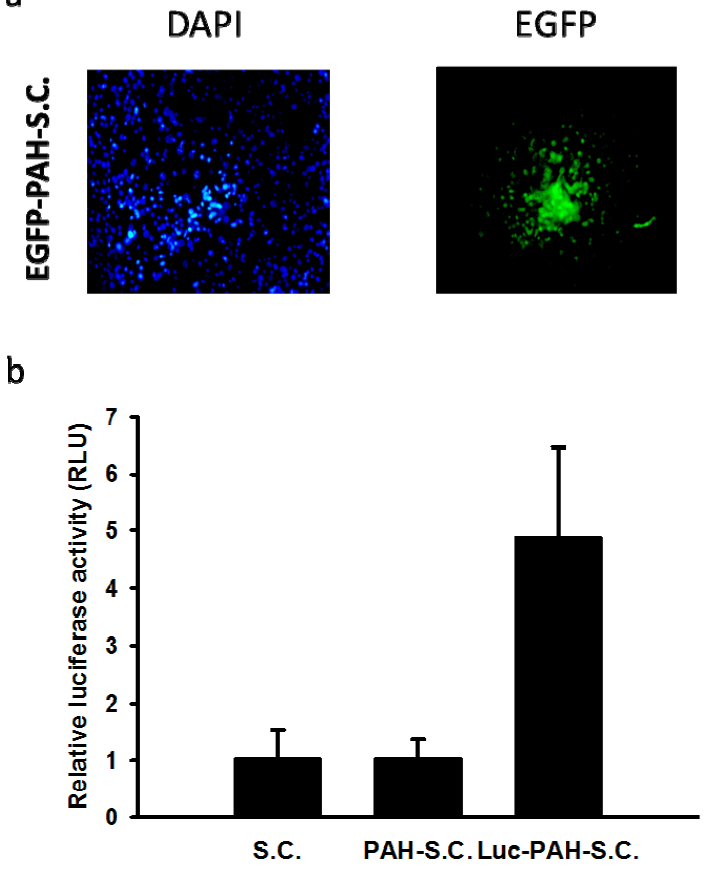
Figure 3. Transduction ability of DNA-PAH-S.C. ( a ) Cells transduced by Salmonella (S.C.) and coated with PAH and EGFP. EGFP was imaged using fluorescence microscopy, and cell nuclei were counterstained with 4 ′ ,6-diamidino-2-phenylindole (DAPI); and ( b ) The effect of DNA-PAH-S.C. on gene transfer in vitro . 4T1 cells were infected with S.C. (10 6 cfu), PAH-S.C. (10 6 cfu), or Luc-PAH-S.C. (10 6 cfu). Luciferase activities in these cells were measured 16 h